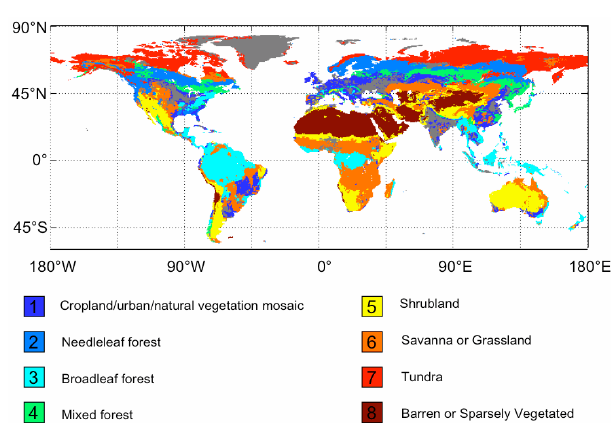
Fig. B1. Land cover classes used for the standard optimizations. Regions that were excluded from the optimisation are shown in grey.